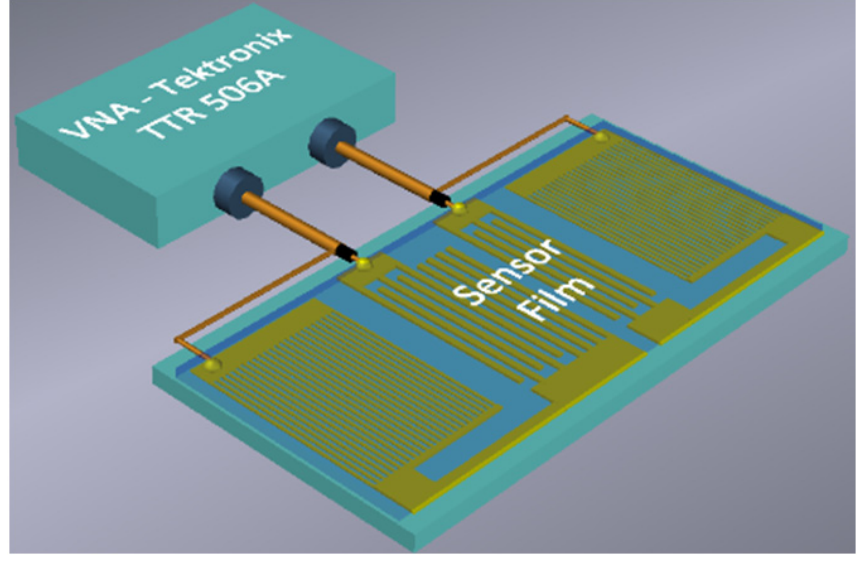
Figure 4. Schematic view of RSAW resonator (device #1) with the sensitive film over the whole propagation path.